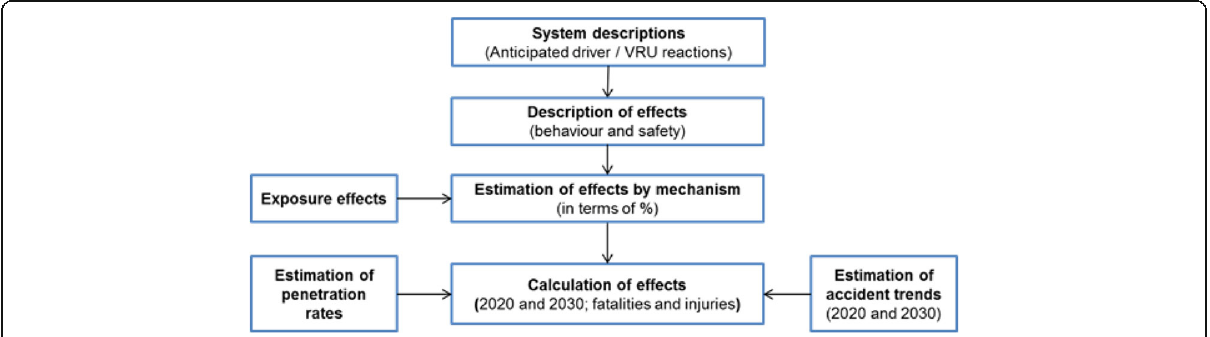
Fig. 2 Description of the overall safety impact analysis method